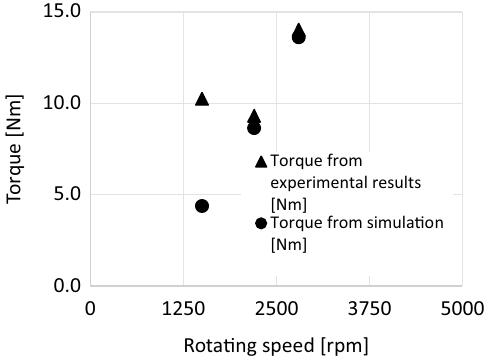
Figure 8. Torque comparison in BCR geometry.